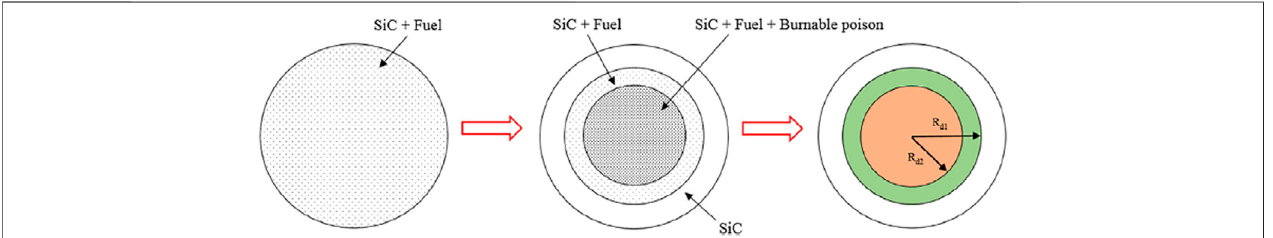
FIGURE 3 | Schematic diagram of the IRPT method.